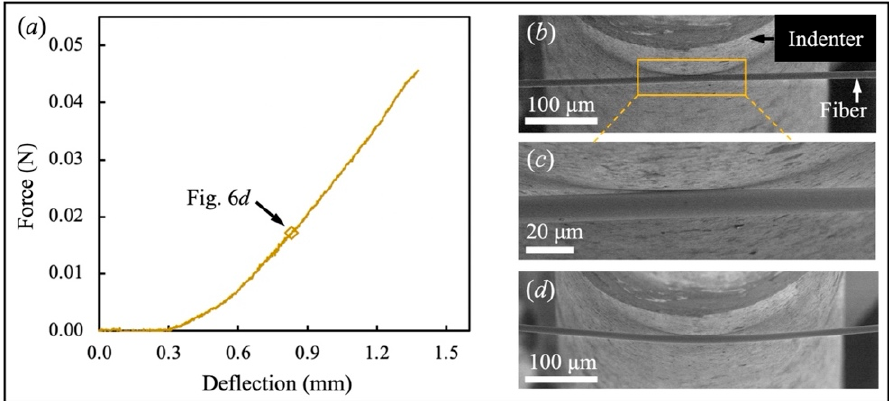
Figure 6. Failure behavior of a representative Slyramic TM ceramic fiber. ( a ) Force-deflection curve; Real-time fiber morphology at S tr = ( b ) 0; ( c ) and ( d ) 0.832 mm.